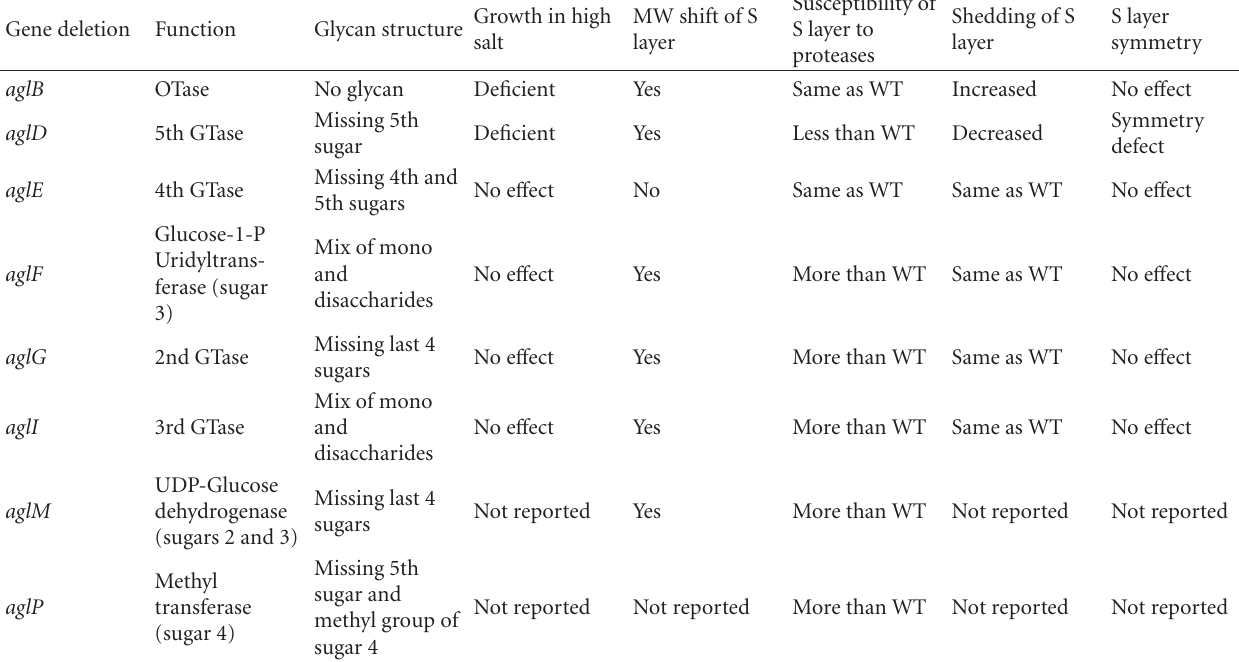
Table 4: E ff ects of agl gene deletions on S layer glycosylation in H. volcanii. Gene deletion